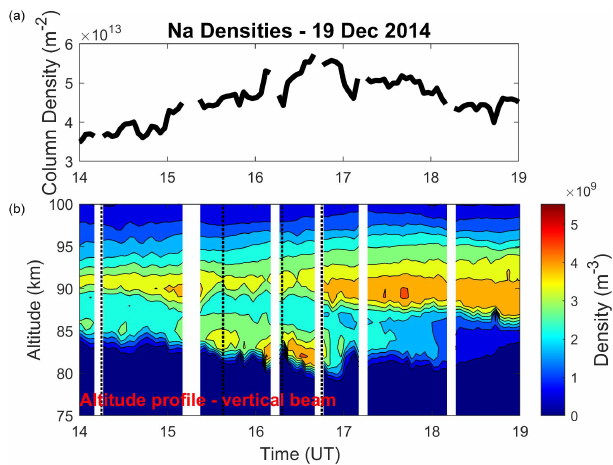
Figure 3. Sodium densities measured by the vertical beam. (a) Col- umn abundance of sodium atoms, (b) range–time–density plot showing coincidence of the column abundance variations with the lower-altitude sodium peak. The dotted black lines in the bottom panel indicate the estimated times of zenith passage of the